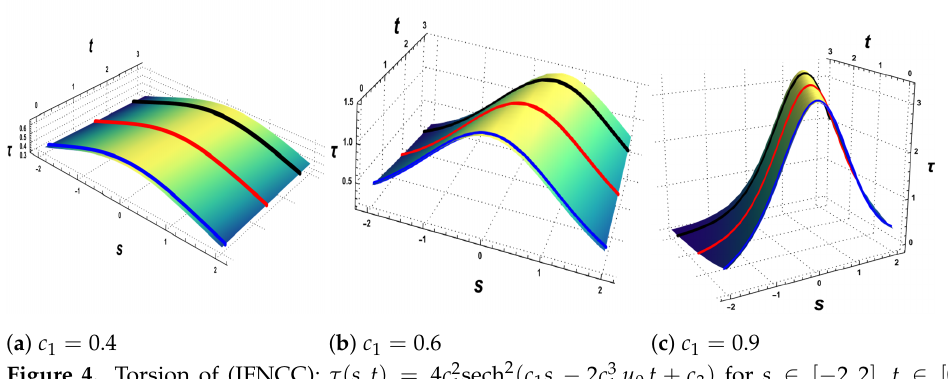
µ 0 t + c 3 ) for s ∈ [ − 2,2 ] , t ∈ [ 0,3 ] , sech 2 ( c 1 s − 2 c 3 1 1